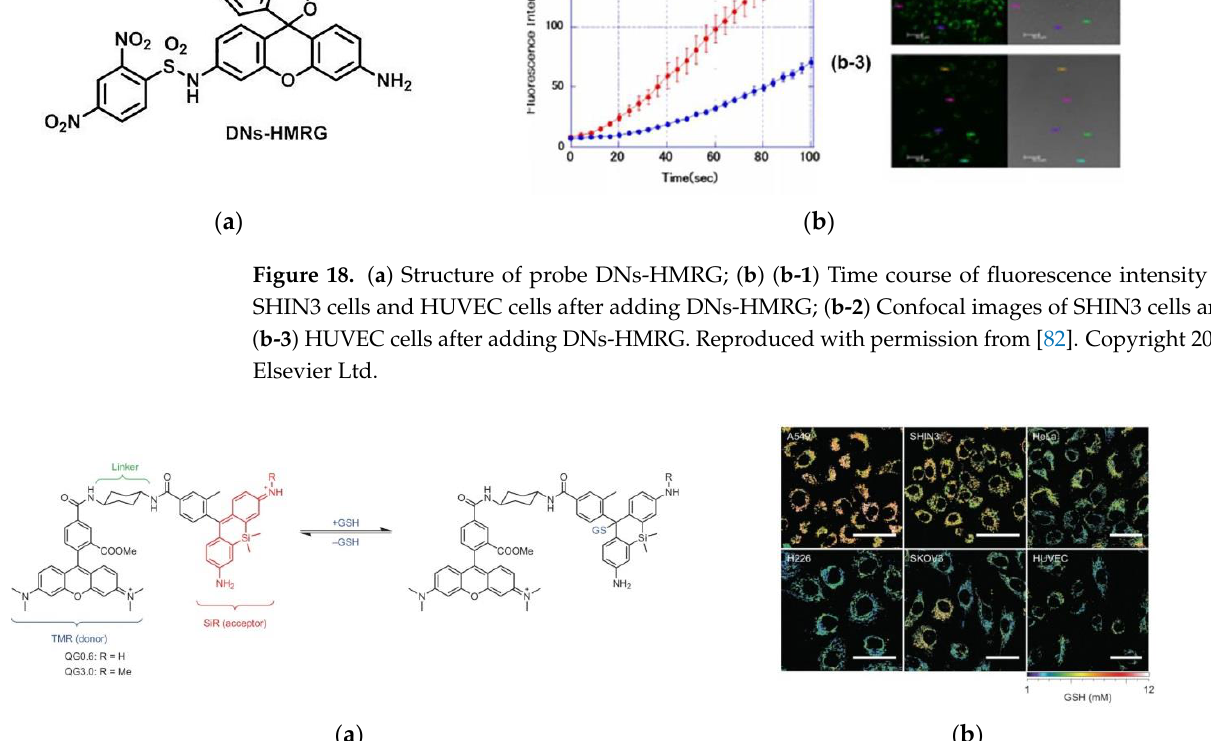
Figure 18. ( a ) Structure of probe DNs-HMRG; ( b ) ( b-1 ) Time course of fluorescence intensity of SHIN3 cells and HUVEC cells after adding DNs-HMRG; ( b-2 ) Confocal images of SHIN3 cells and ( b-3 ) HUVEC cells after adding DNs-HMRG. Reproduced with permission from [82]. Copyright 2014 Elsevier Ltd.